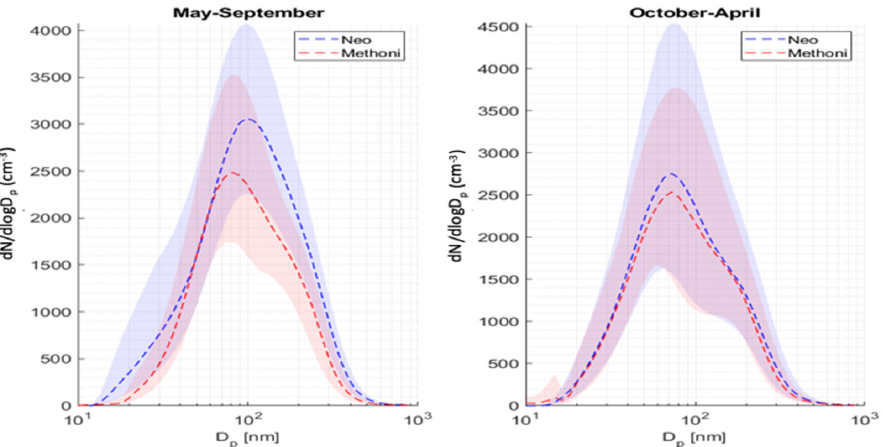
Figure A1. Seasonal averages for aerosol number size distributions observed at NAVARINO and Methoni, respectively. Colored areas indicate 25–75th percentile ranges and dashed line represent median.